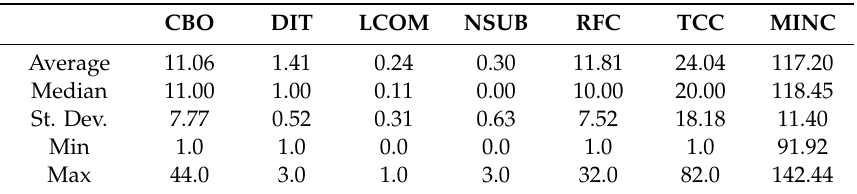
Table 11. Descriptive statistics about C&K software metrics and MINC of the httpcore project source code files used in the